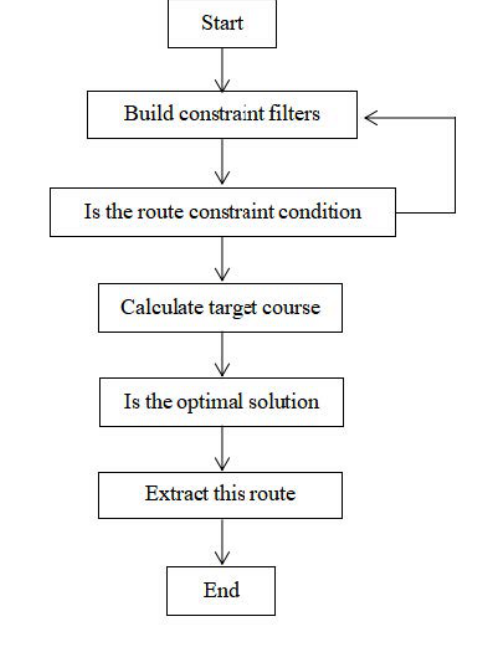
Fig. 1 Mathematical solution process of ship